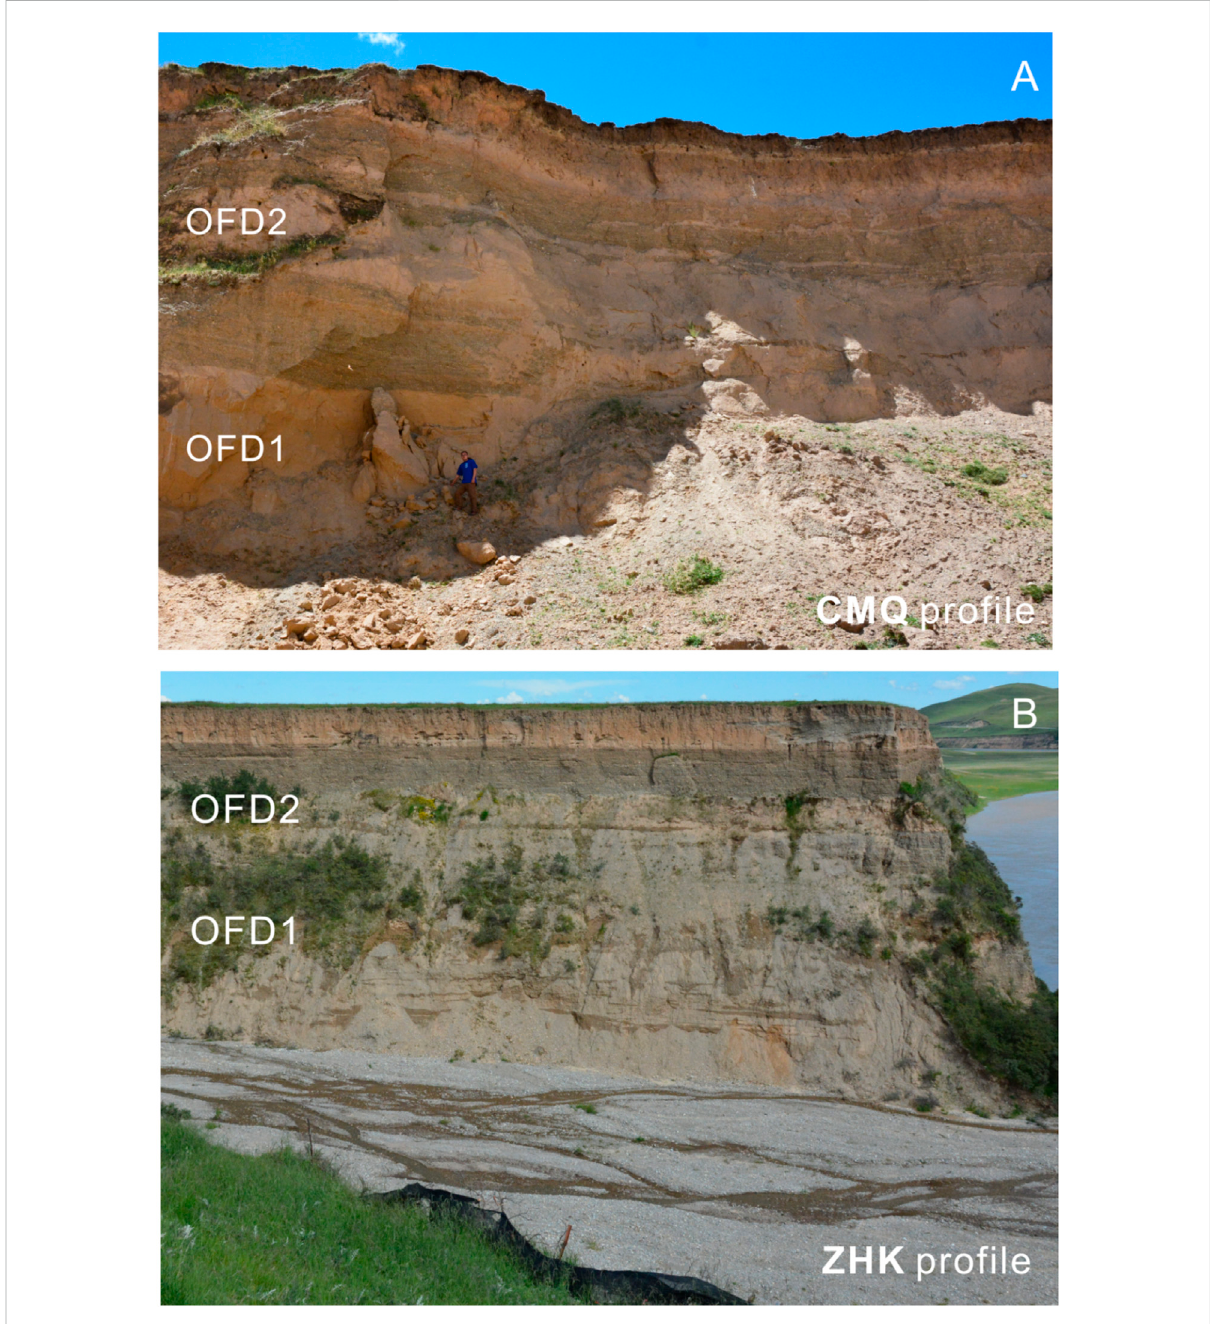
FIGURE 3 Photo showing the overbank fl ood deposits within the sediment pro fi les at the CMQ and ZHK sites in the Yellow River source area on the NE Tibetan